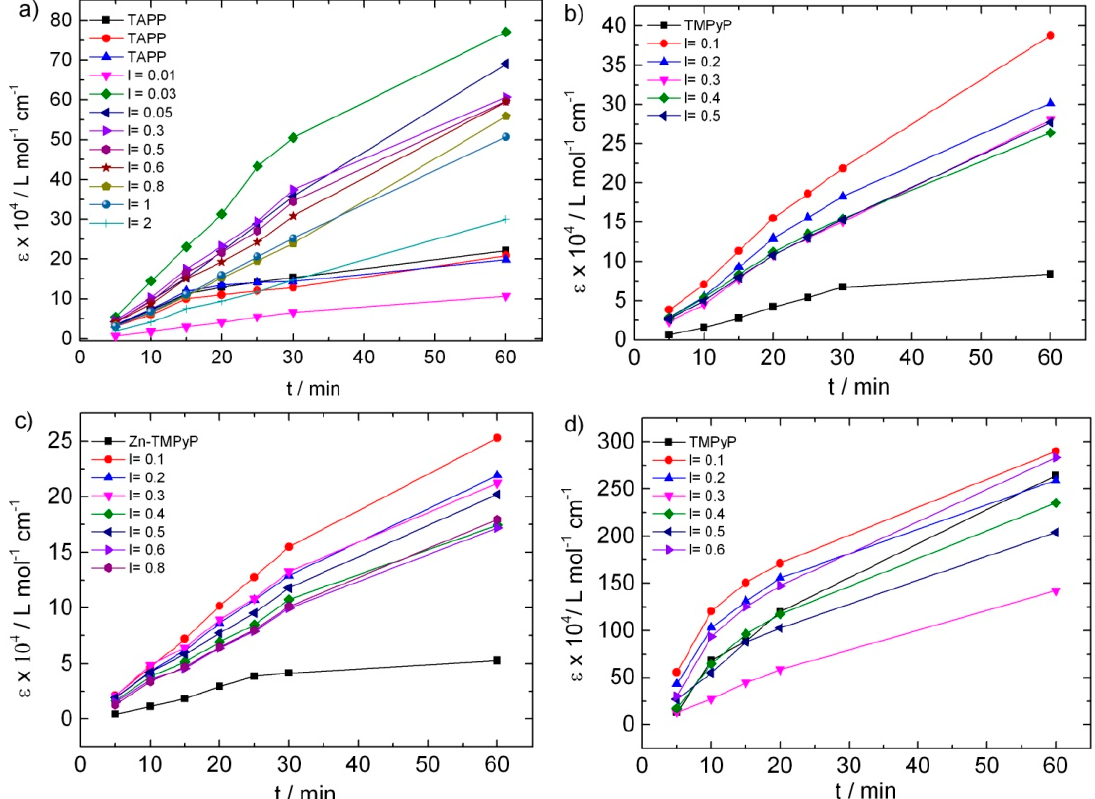
Figure 4. Kinetics of tri-iodide formation: extinction coefficient ε at λ = 353 nm versus irradiation time for samples in acidic iodide solution: ( a ) TAPP diacid-PSS brush; ( b ) TMPyP monoacid-PSS brush; ( c ) Zn-TMPyP-PSS brush; ( d ) TMPyP diacid-PSS brush.